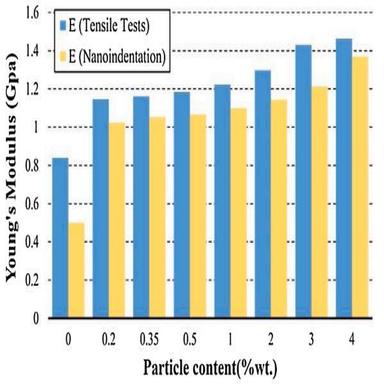
Compared Young's modulus from nanoindentation and tensile tests for fiber-reinforced composites with same compositions.